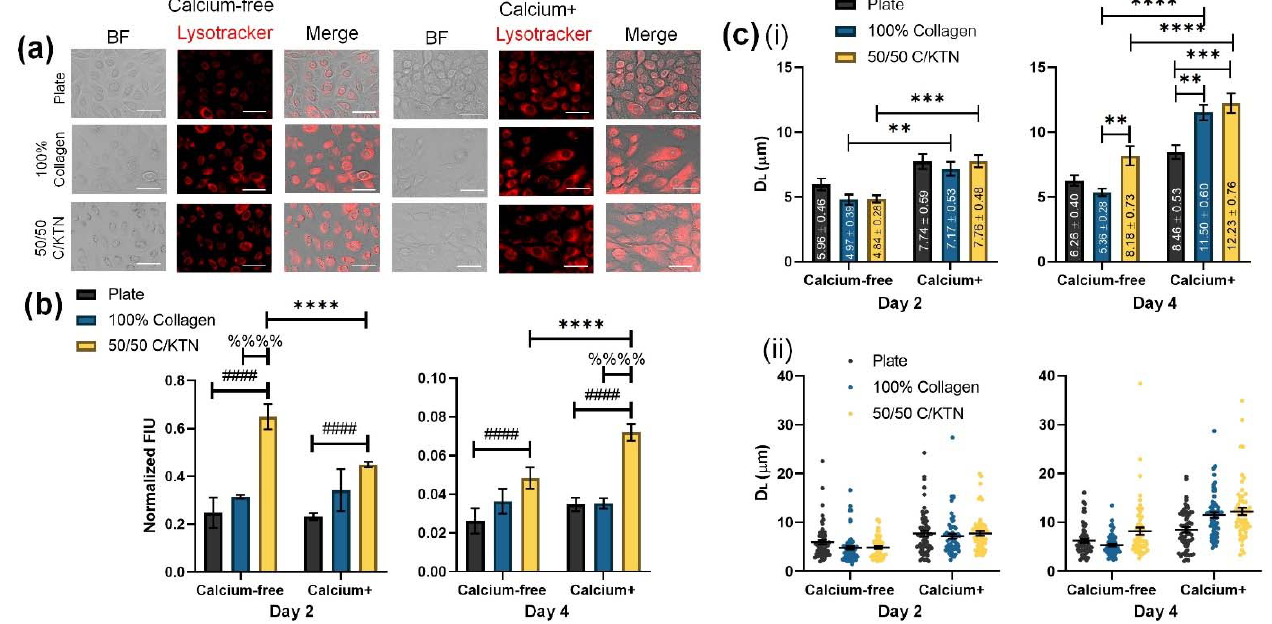
Figure 3. LysoTracker lysosome staining of proliferative and differentiated keratinocytes. Day 2 and day 4 keratinocytes seeded on either a plate or a hydrogel were stained with LysoTracker DND-99 dye to visualize lysosomal distribution, with day 2 shown ( a ). Fluorescence intensity units (FIUs) of stained lysosomes were measured and normalized to cell viability at days 2 and 4 post-calcium switch ( b ), with a significant increase observed for 50/50 C/KTN hydrogels compared to the plate and 100% collagen samples with and without calcium (n = 4, weighted average ± SD; * = day 2 vs. 4 for 50/50 C/KTN, # = 2D plate vs. 50/50 C/KTN, % = 100% collagen vs. 50/50 C/KTN). The D L ( c ) at day 2 showed no significant differences between groups, but increased when calcium was added to the medium ( i ). Significant increases in D L were observed with 50/50 C/KTN when compared to the plate and 100% collagen at day 4 (n = 60, average ± SEM). Each measurement of D L is also plotted to show the distribution ( ii ). Two-way ANOVA was performed for both normalized FIU and D L ; for all plots. The different symbols (*, #, %) correspond to the comparisons and the number of symbols correspond to the p-value for each comparison: * = p < 0.05, ** = p < 0.01, *** = p < 0.001, **** = p < 0.0001; * = 2D plate vs. 100% collagen, # = 2D plate vs. 50/50 C/KTN, % = 100% collagen vs. 50/50 C/KTN. Scale bar = 100 µ